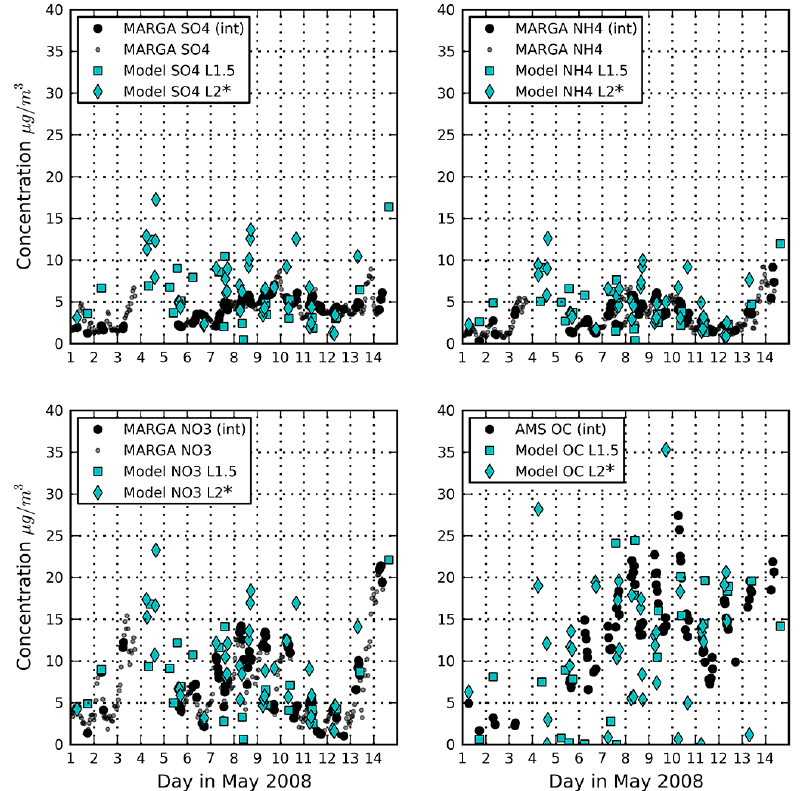
Figure 9. Inorganic salt ion concentrations, SO 2 − (upper left), NH + (upper right), NO − (lower left) from surface observations of the 4 4 3 MARGA (small grey dots), and organic matter (OC) from Jülich ICG-2 AMS (scaled to PM 10 , lower right), interpolated to AERONET times (bold black dots) and compared to the column-average model results (turquoise squares and diamonds for data based on AERONET L1.5 and L2 ∗ data, respectively). Results based on suspect AERONET data have been left out.